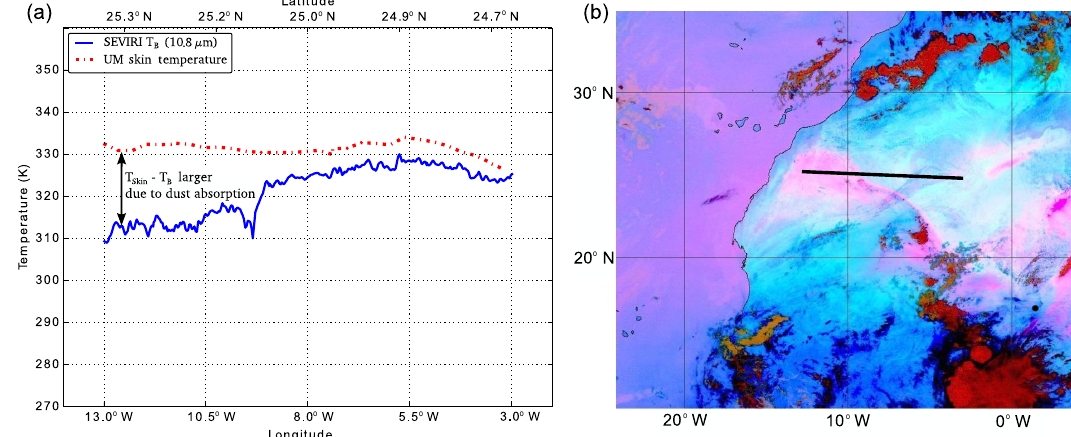
Figure 10. (a) Cross section of the Sahara from 20 June 2011 at 14:30UTC, showing how MetUM model skin temperatures (used as an input to the CTH calculations) compare with SEVIRI brightness temperature in the IR. (b) Dust RGB showing the location of the cross section in (a) as a black line. Areas of high dust loading show up in bright pink/magenta. The difference between SEVIRI T B and model T skin is larger in the dusty area to the west, likely due to absorption by the